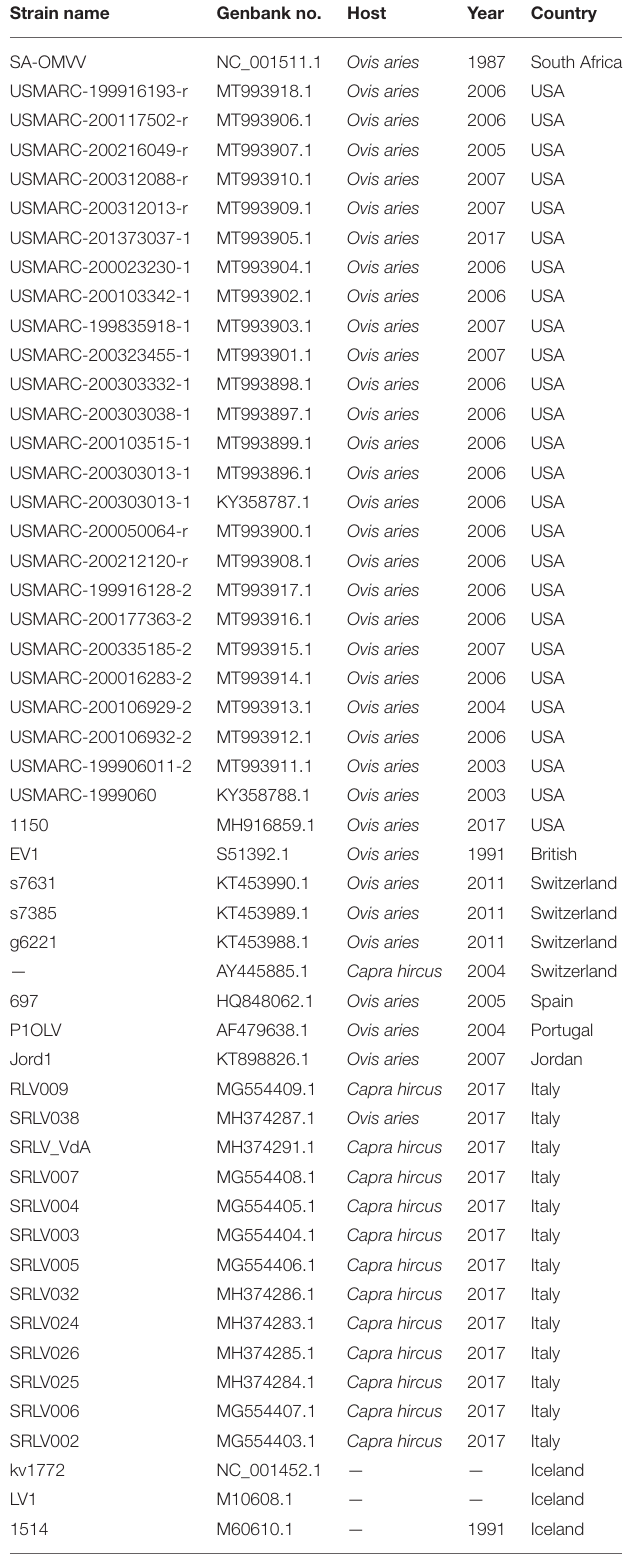
TABLE 1 | Primers used for PCR amplification. Segment Primer Sequence